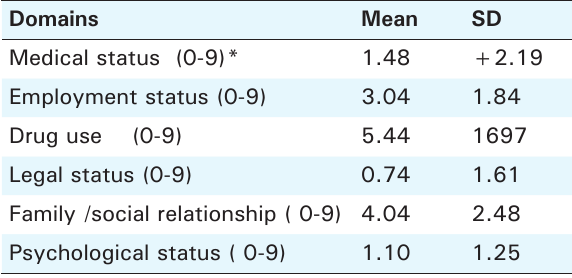
Table 8. Severity of addiction (subjective) in subjects